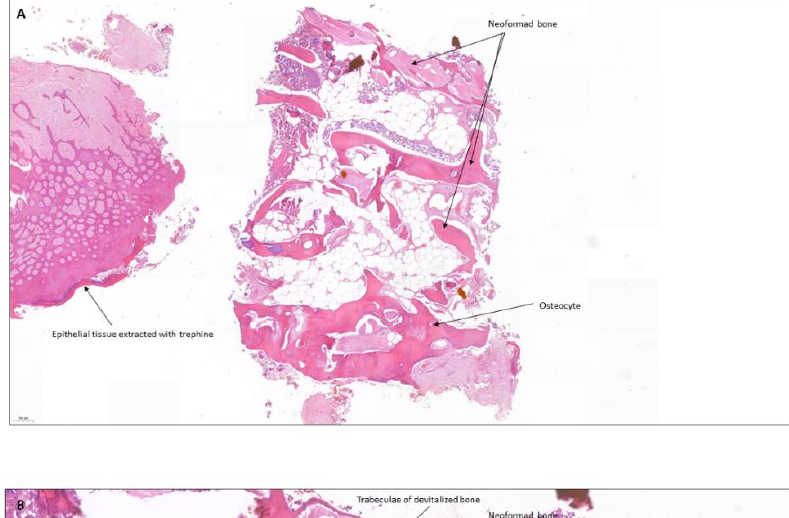
Figure 22. Intraoperative photographs.